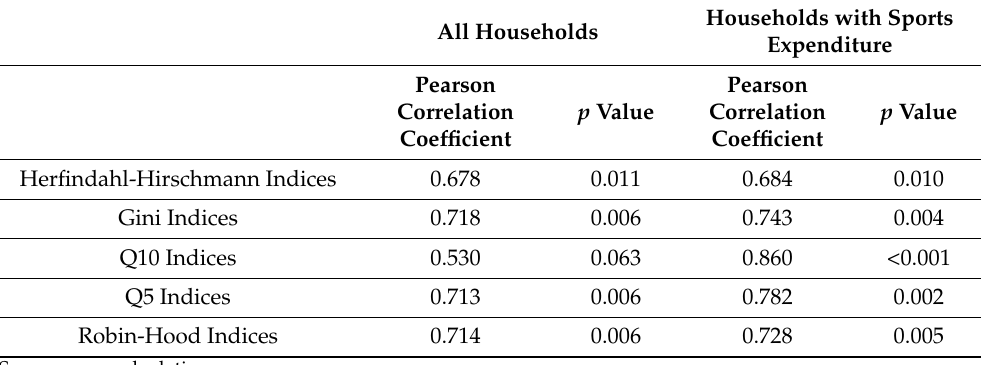
Table 7. The correlations between household net income inequality indices and sports expenditure.